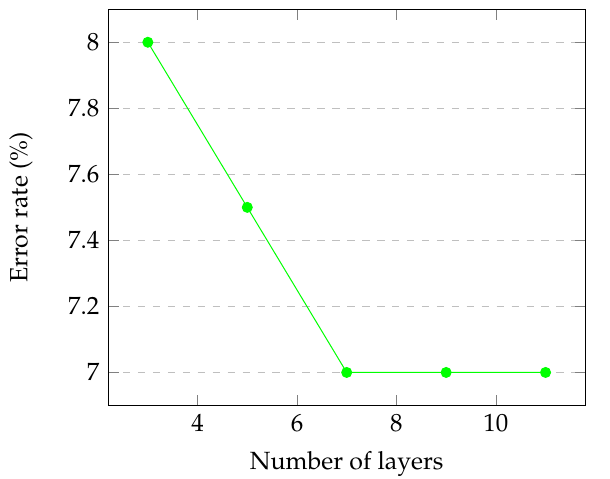
Figure 1. The relationship between the number of neural network layers and the error rate of our proposed